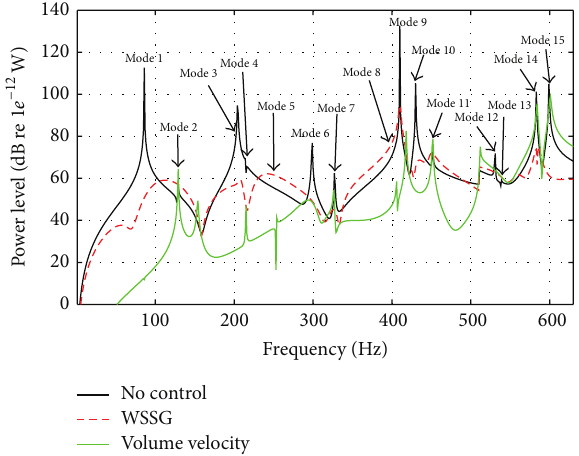
Figure8:Soundradiatedbythefirstradiationmodeontheclamped rectangular plate.